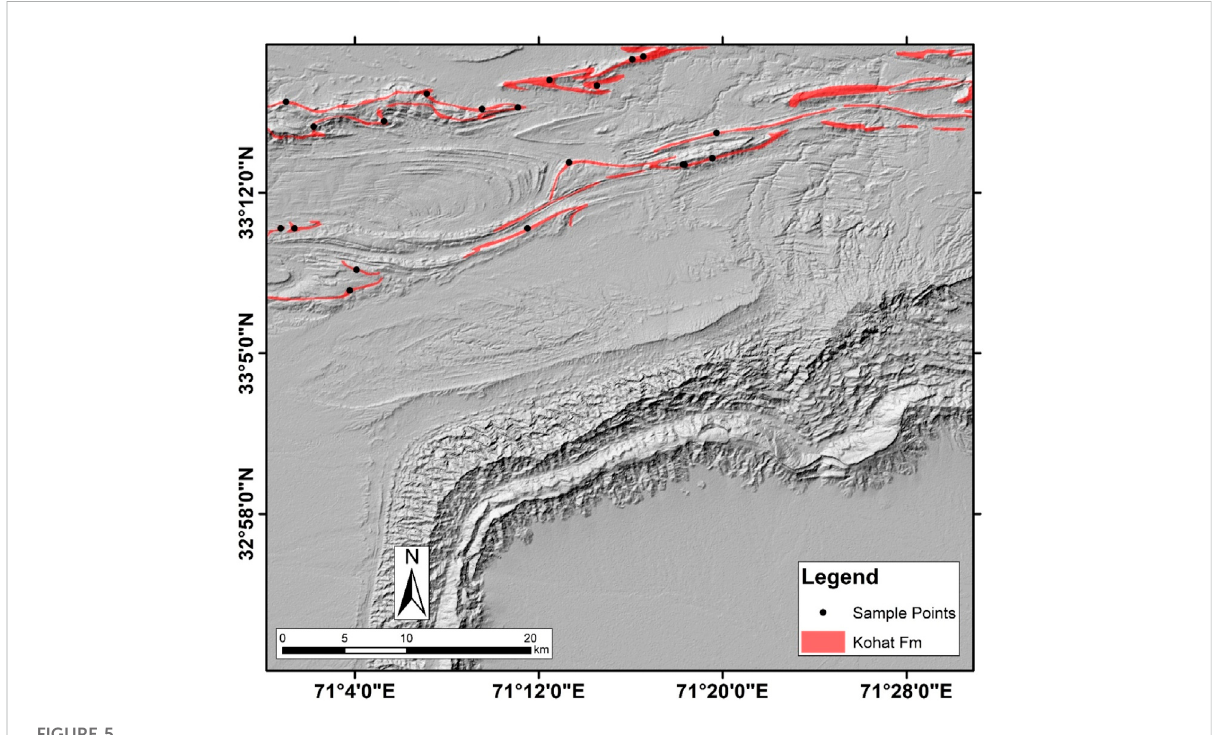
FIGURE 5 Location for radon measurement in the limestone unit of the study